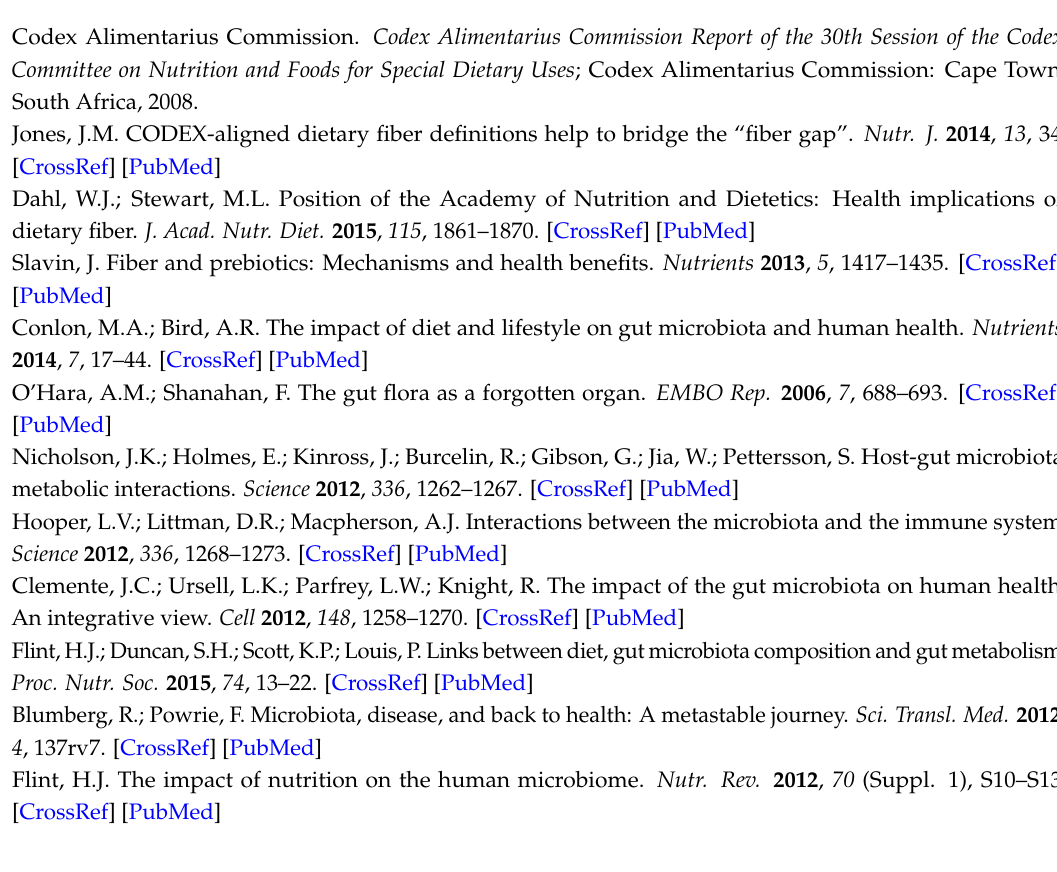
Table S1: Inclusion/Exclusion Criteria. Supplementary Methods. Figure S1: Acute studies: weighted scatter plot of other microbiota outcomes by fiber group presents weighted scatter. The acute studies exclusively examine the short-term fermentation response by measuring SCFA concentration and/or breath gas excretion, most frequently in cereal fibers. Figure S2: Longer duration studies: weighted scatter plot of other microbiota outcomes by fiber group. Studies of greater duration examine more outcomes in a larger array of fiber types. Notably, however, there are no longer duration (>4 weeks) studies on resistant